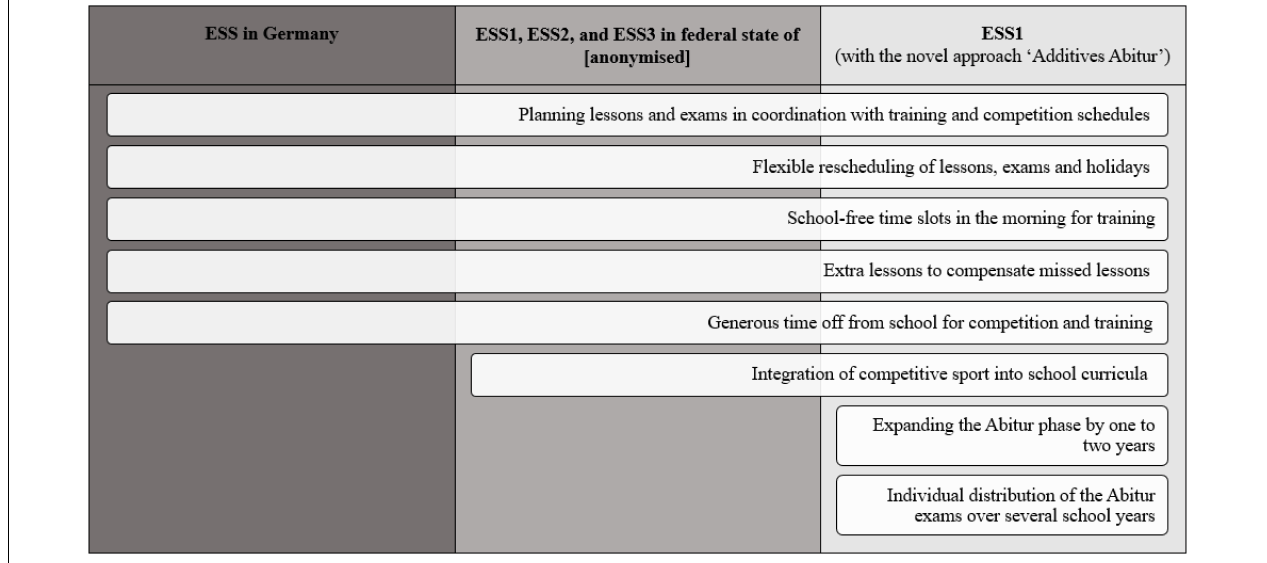
“Vocabulary and Reading.” The English test has been shortened